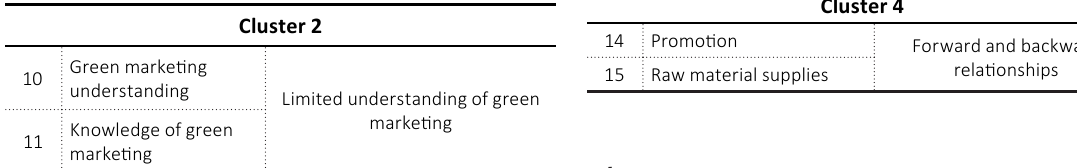
Table 5. Codes comprising Cluster 4